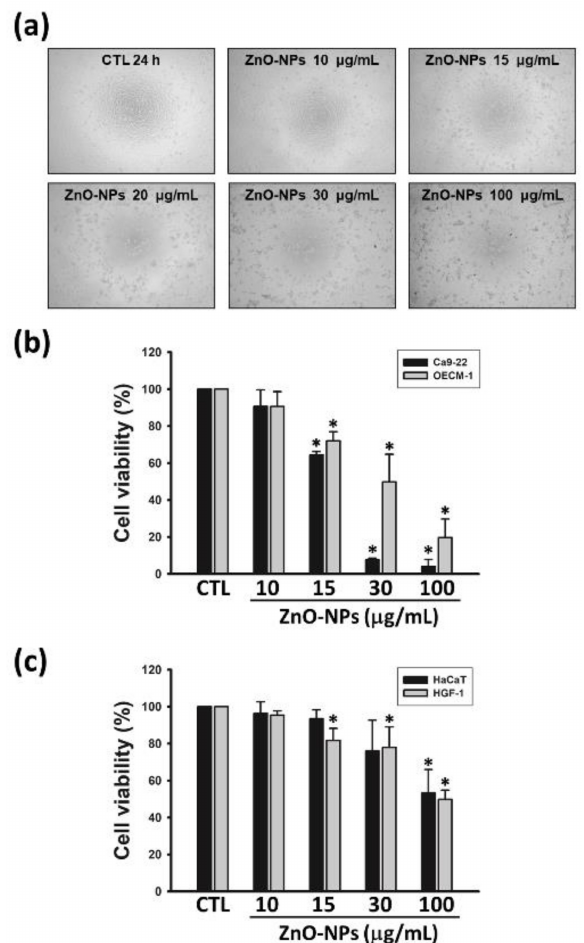
Figure 1. E ff ects of zinc oxide nanoparticles (ZnO-NPs) on cell growth in human gingival squamous cell carcinoma (GSCC) and normal cells. Ca9-22 or OECM-1 cells were incubated with the indicated concentrations of ZnO-NPs for 24 h. The cell morphology ( a ) and viability ( b ) were assessed by the inverted phase contrast microscope and MTT assay, respectively. ( c ) Human normal keratinocyte cells (HaCaT) and gingival normal cells (HGF-1) were treated with the indicated concentrations of ZnO-NPs for 24 h, then cell viability was determined using MTT assay. Data represent the mean ± SEM of four independent experiments. * p < 0.05 compared with the control